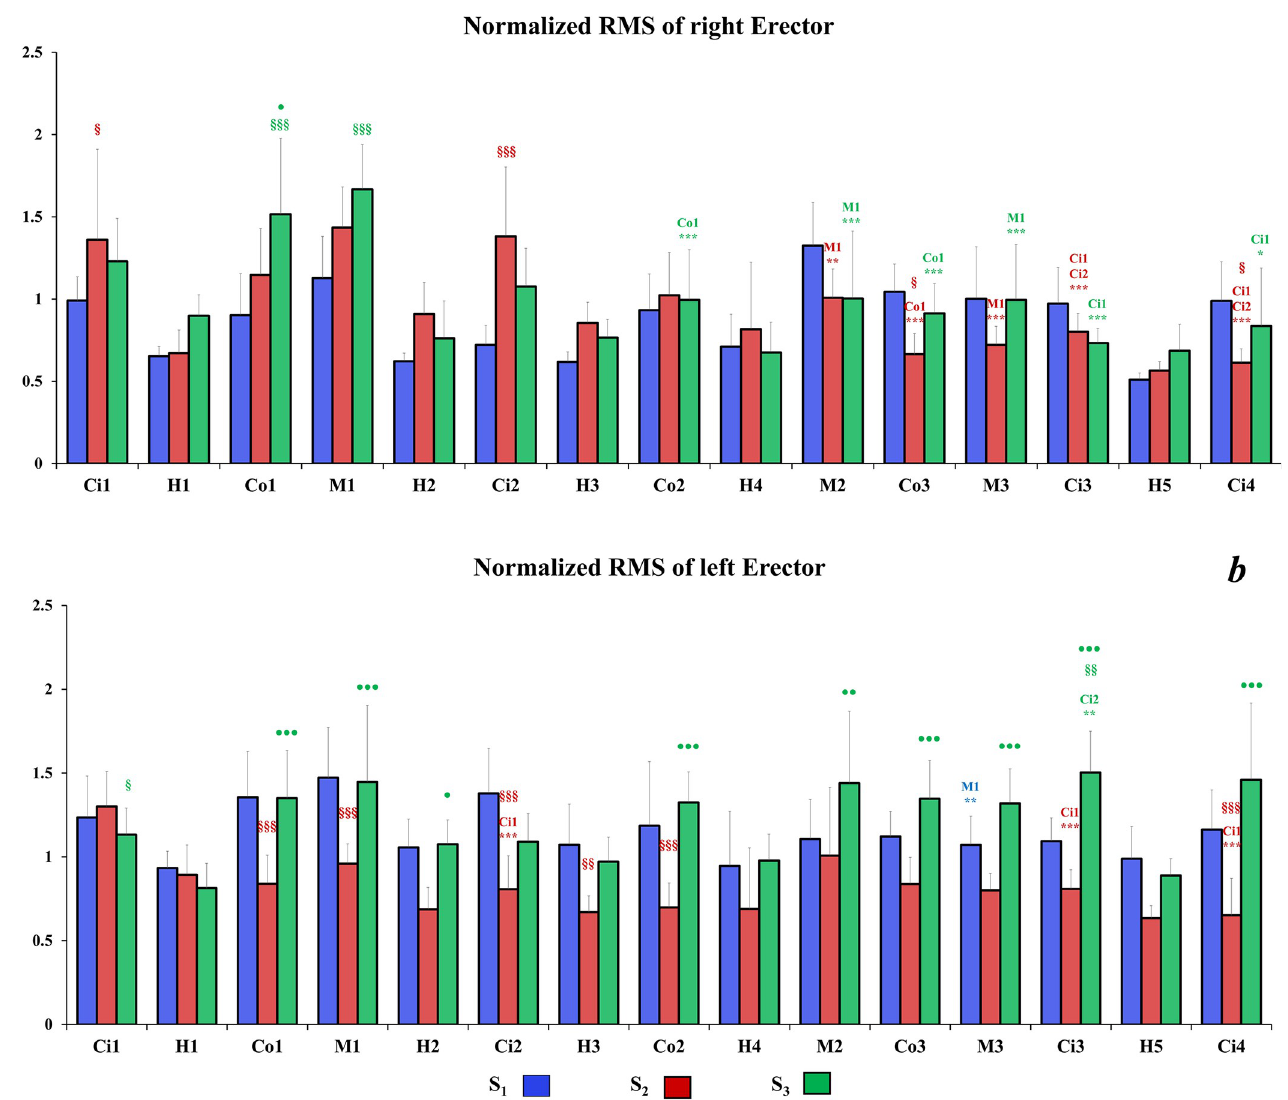
Fig 7. Mean of right (a) and left (b) ESL normalized RMS values for each road sector for all seats. Significant differences between sectors of a same road type are symbolized by � (sectors concerned by the significant differences are mentioned above � ); significant differences between S 1 and other seats for a same road sector §; significant differences between S 2 and S 3 seats for a same road sector ●